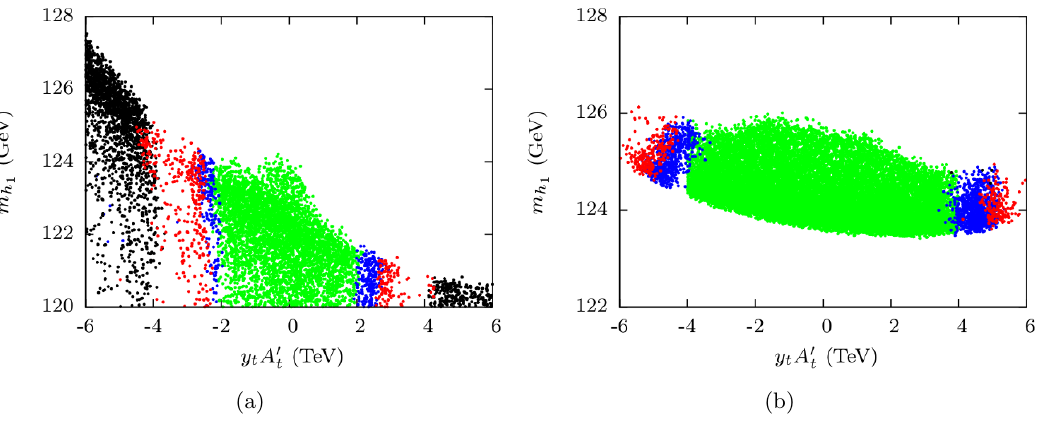
Figure 4 . The stability pro(cid:12)le of DSB minima in y t A 0 eq. (3.3). Figures 4(a) and 4(b) correspond to (5 < tan (cid:12) < 10) and (40 < tan (cid:12) < 50) respectively. The color codes are same as that for (cid:12)gure